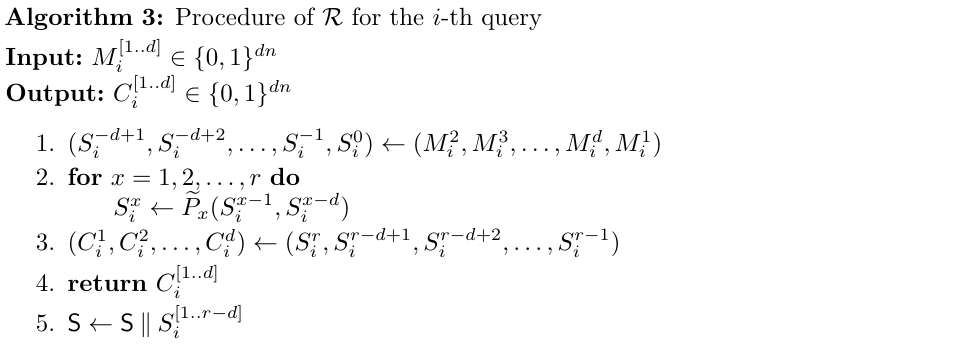
Algorithm 3: Procedure of R for the i -th query